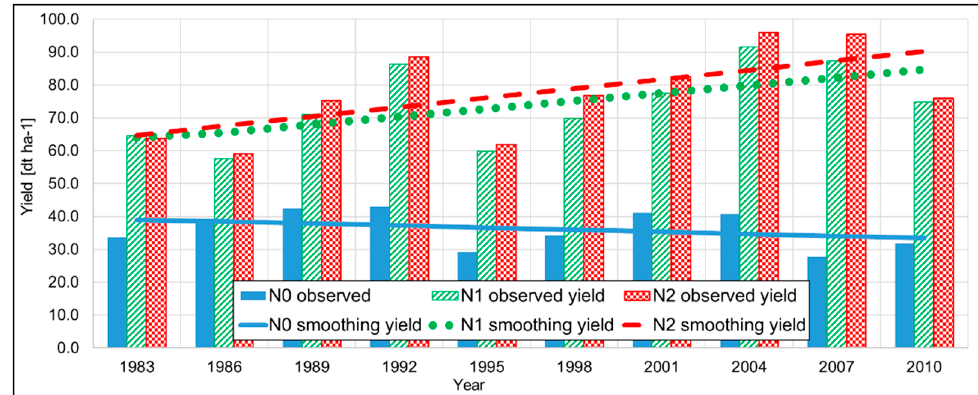
Figure 2. Annual yields of winter wheat between 1983 and 2010 with the smoothing lines for the fertilized and control plots (N0 unfertilized plots, low fertilized plots N1, high fertilized plots